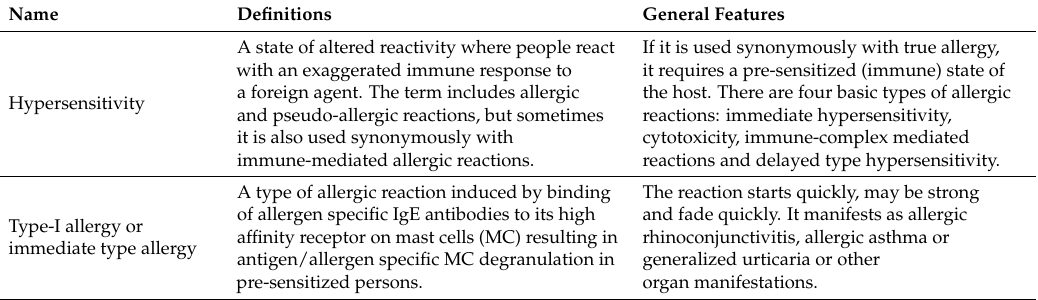
Table 1. Definitions and general features of different